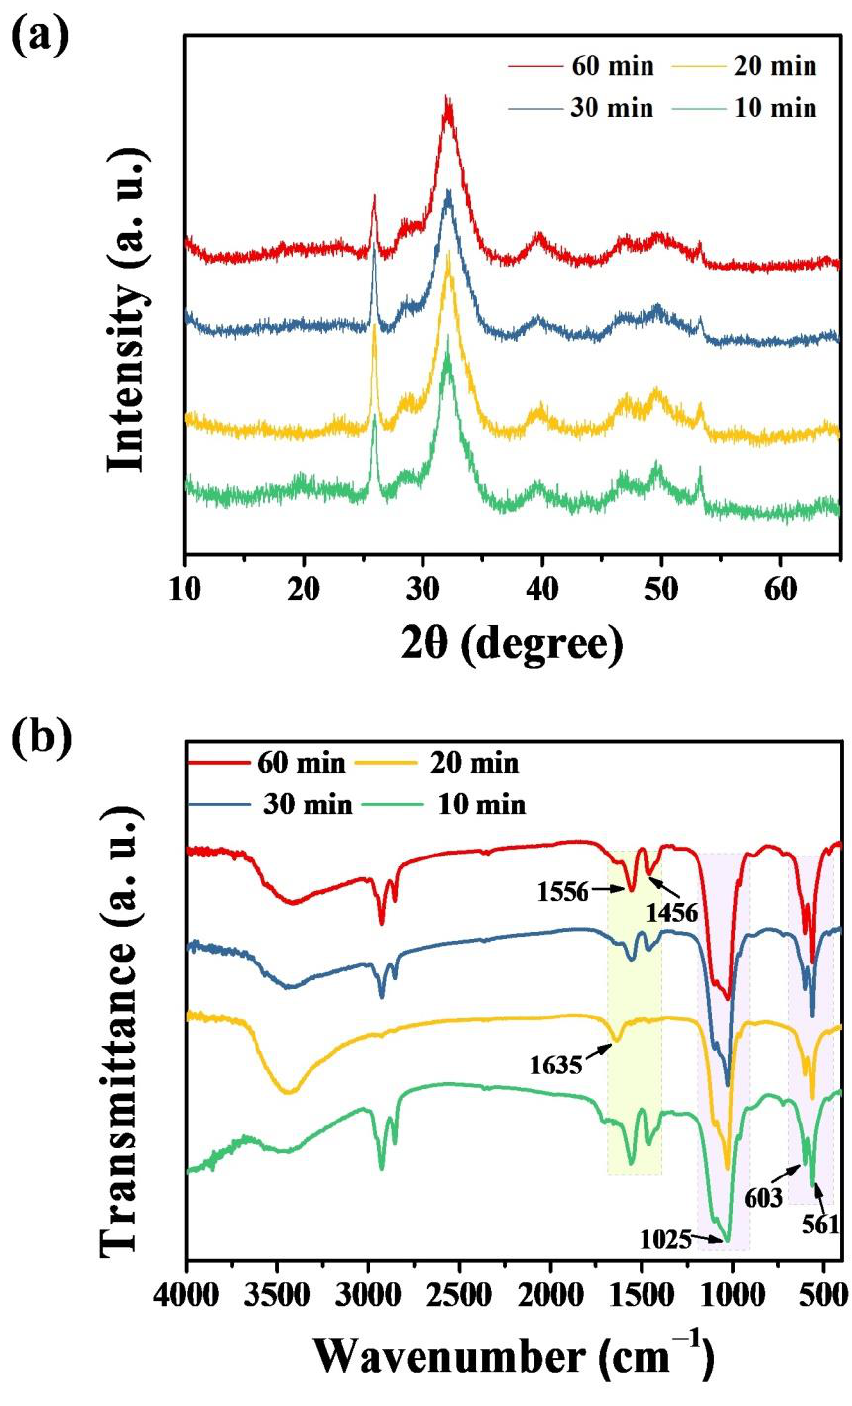
Figure 6. XRD patterns ( a ) and FTIR spectra ( b ) of products prepared using ATP as a bio-phosphorus source in aqueous solution by the calcium oleate precursor microwave hydrothermal method at 180 °C for different times.